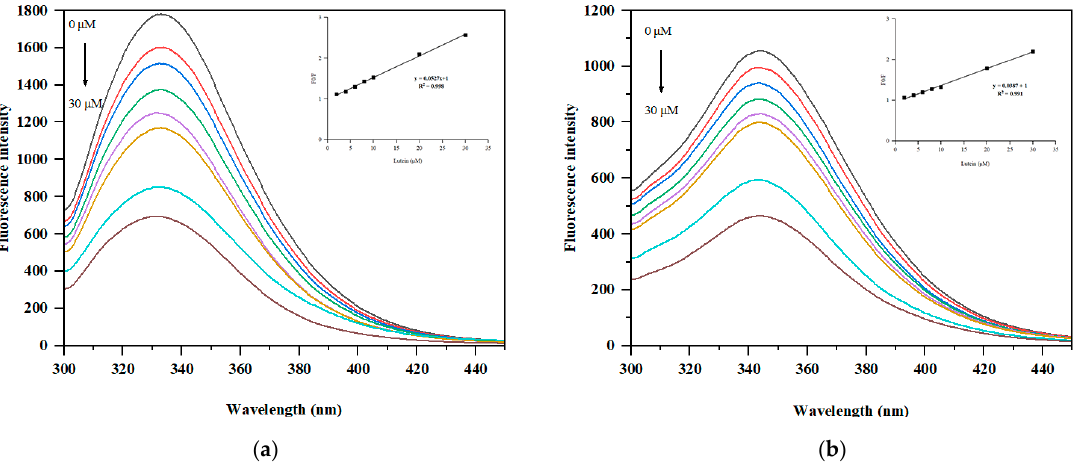
Figure 4. ( a ) Fluorescence emission spectra of SPI; ( b ) Fluorescence emission spectra of PSPI. protein concentration was 0.4 mg/mL and the lutein additive amount was 0, 2, 4, 6, 8, 10, 20, and 30 μ M.